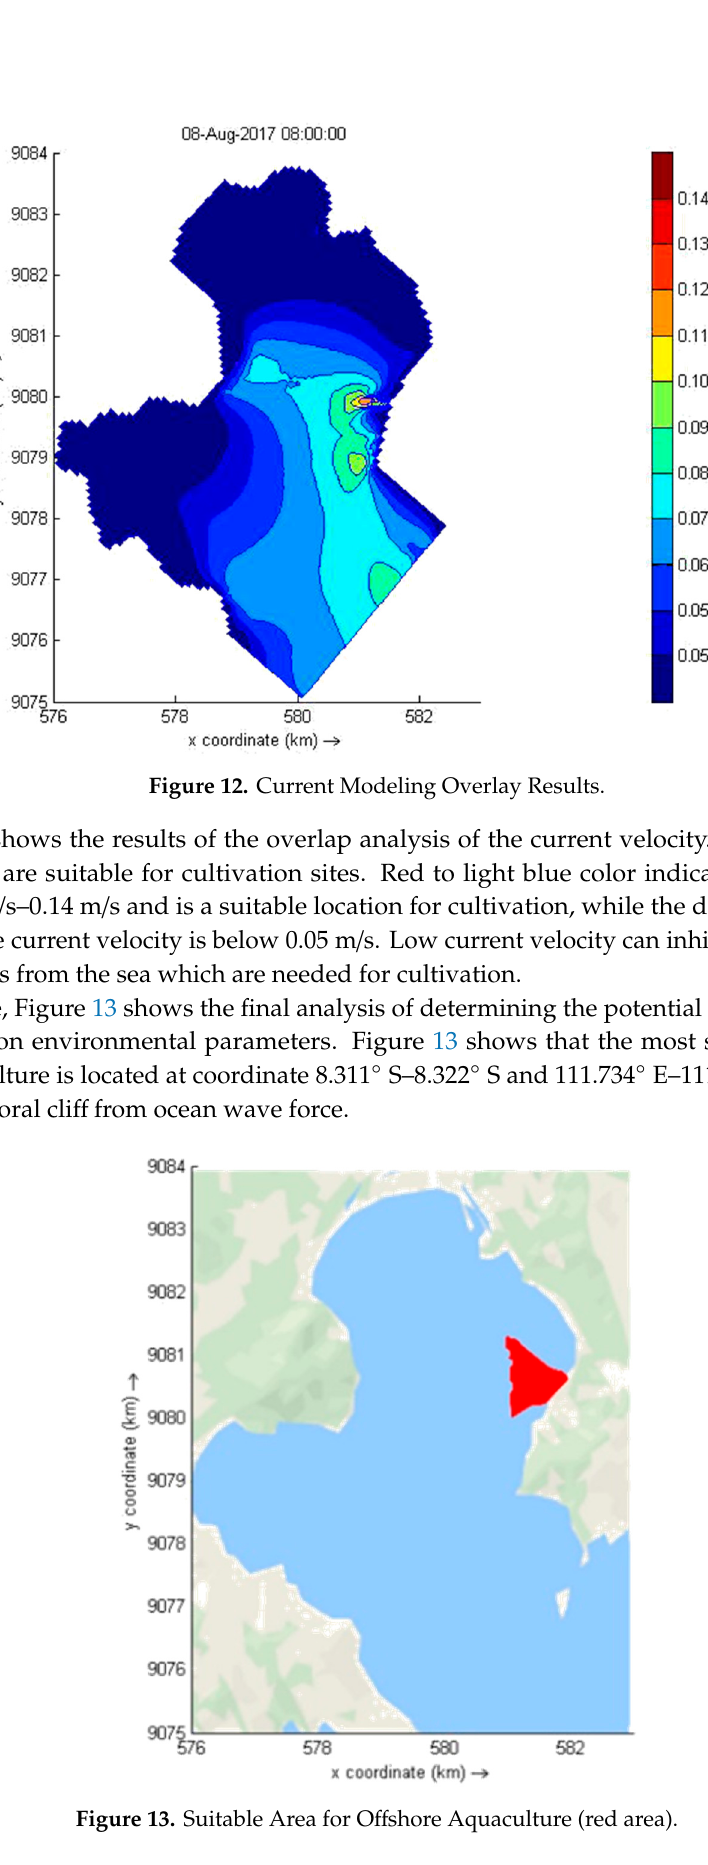
Figure 11. Results Overlay Modeling of Wave 12 Months.